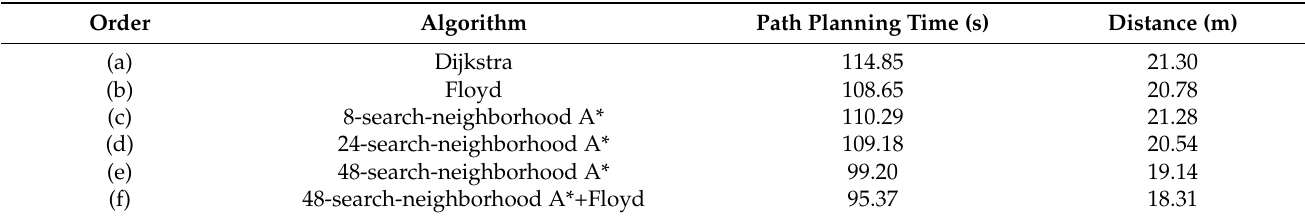
Table 2. Comparison of path planning time and distance of different algorithms in an actual